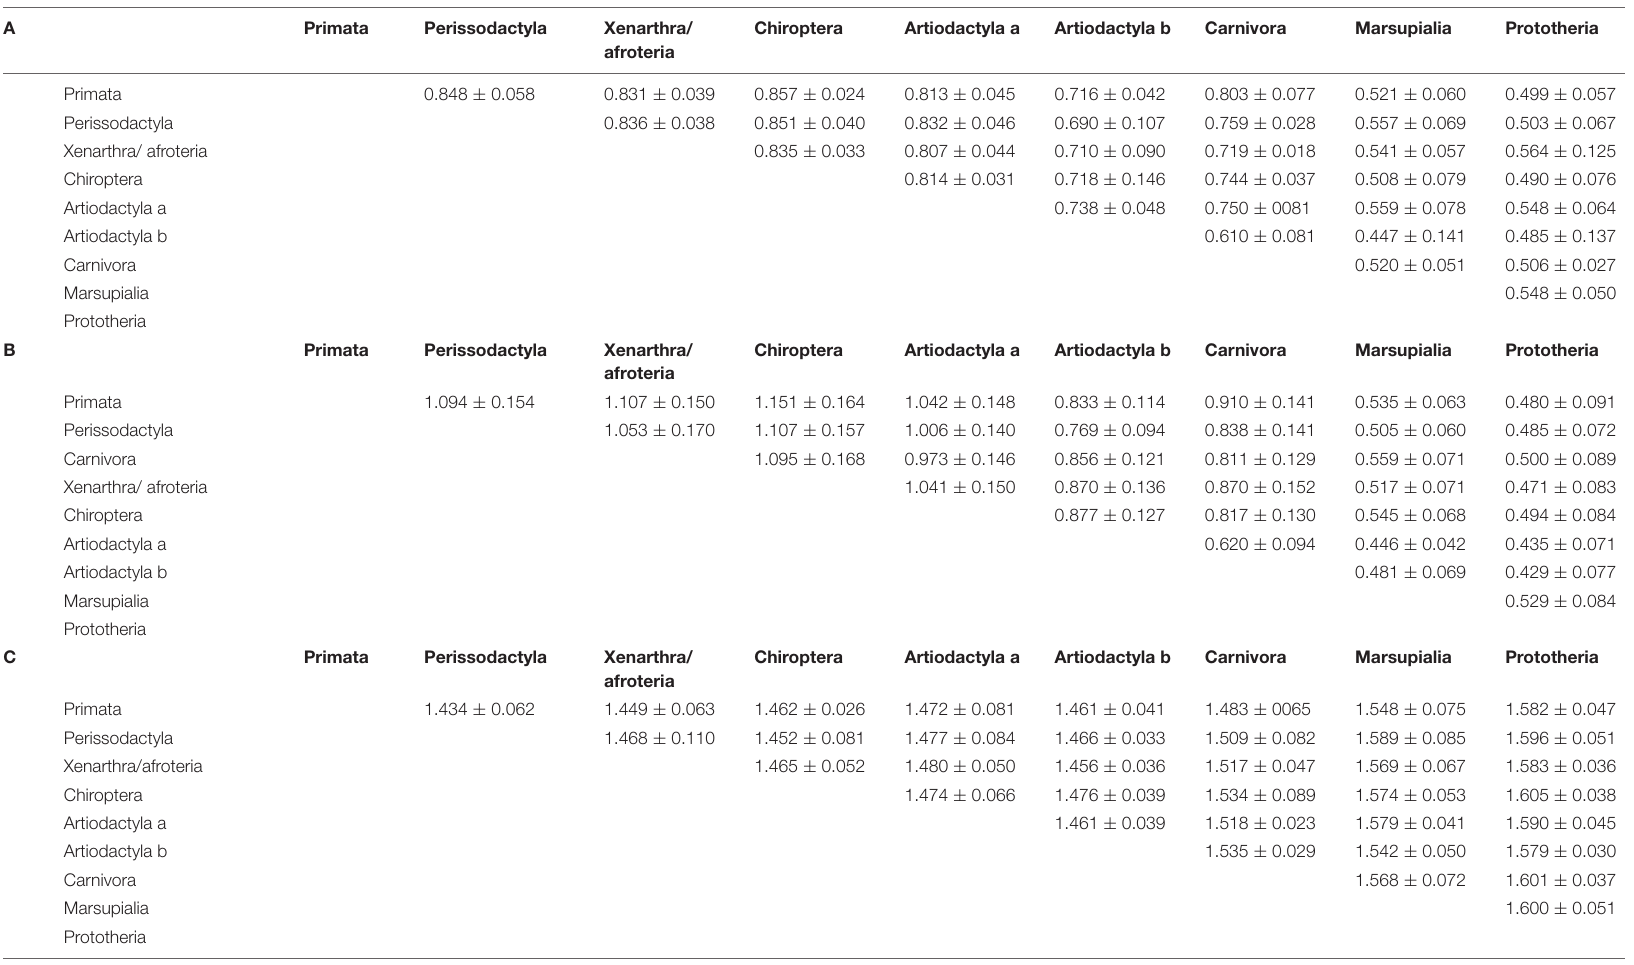
TABLE 2 | Overall relatedness of Osteopontin sequences among